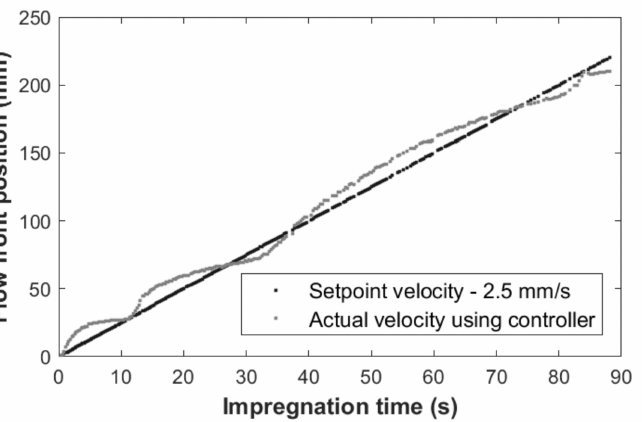
Figure 5. Impregnation process. Flow front position in [90 2 , 0] S stitched specimen: the target of 2.5 mm/s (grey) and the real value